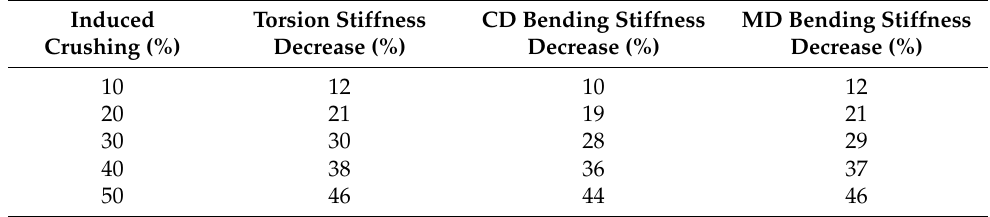
Table 7. The decreases in stiffness of torsion, bending in CD and bending in MD for scaling factors separately identified for region A and region B – obtained for different input geometry due to induced crushing (see Figure